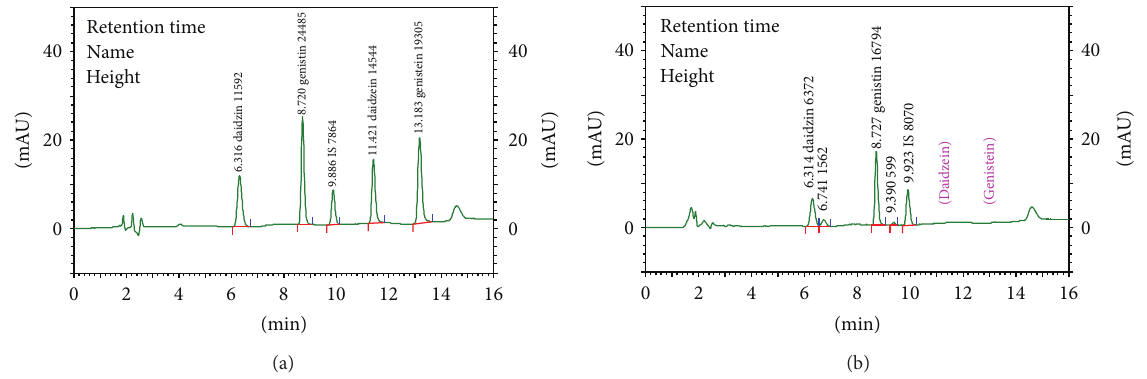
Figure 2: (a) Chromatogram of isoflavones in a standard mixture of daidzin, genistin, daidzein, and genistein (6,000ng/mL, each) and internal standard (IS, fluorescein 10,000ng/mL). (b) Chromatogram of soybean seed sample (SJ 2 grown at SUT Farm) extracted with 80% methanol plus 2M